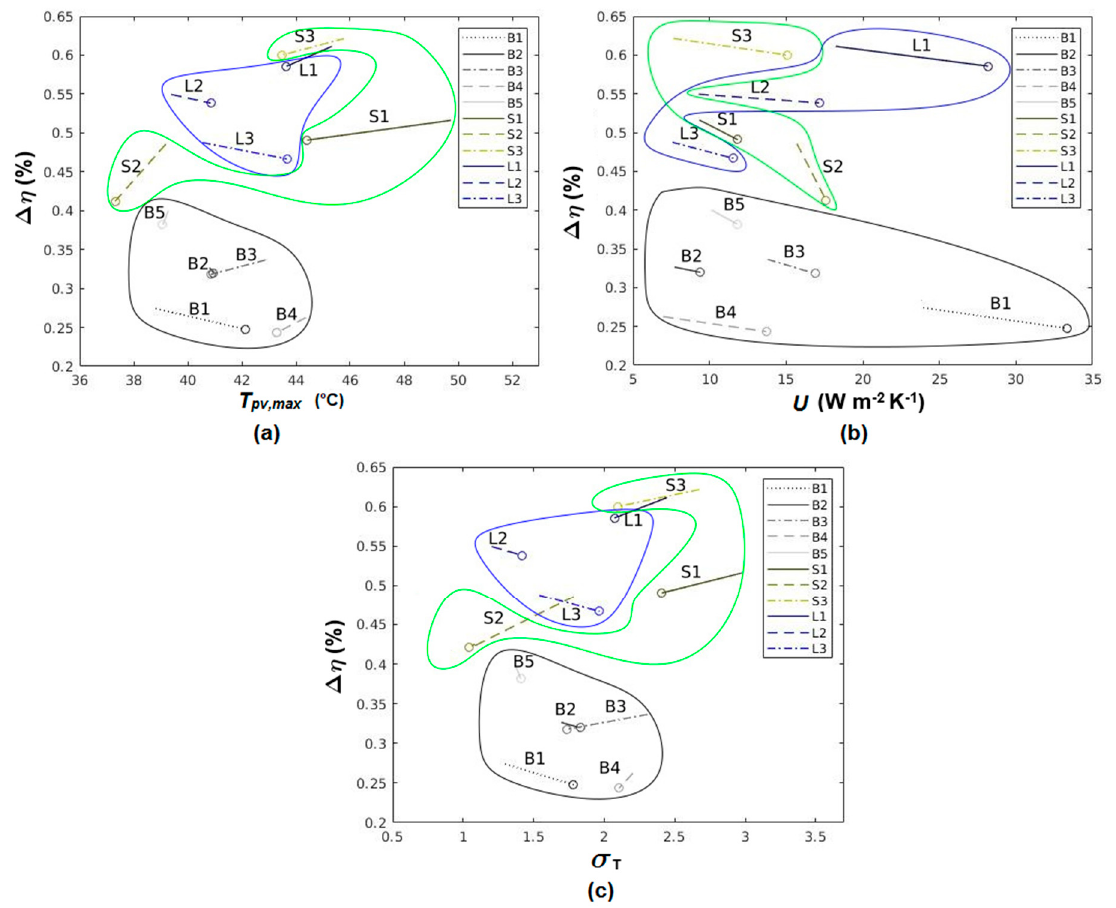
Figure 12. Effect on the efficiency drop ( Δ η ) of: ( a ) maximum PV module temperature ( T PV,max ), ( b ) overall heat transfer coefficient ( U ), and ( c ) standard deviation of temperature distribution ( σ T ). Data points for the same configuration are joined by a line, with the unmarked ends of the lines representing the data at Q w = 1 L min − 1 , and the ends marked with a circle representing the data at Q w = 2 L min − 1 .